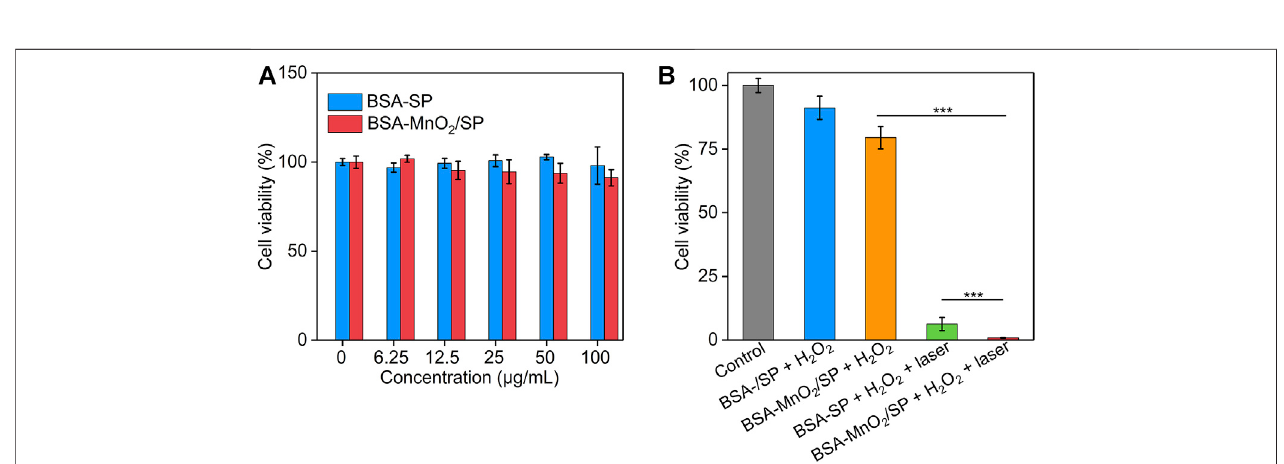
FIGURE5| Evaluationof invitro therapeuticef fi cacy. (A) CellviabilityofHepG2cellsafterincubationwithBSA/SPnanoparticlesorBSA-MnO 2 /SPnanocomposites at differentSPconcentrationsfor24 h. (B) CellviabilityofHepG2cellsafter incubation withBSA/SP nanoparticles orBSA-MnO 2 /SPnanocompositesin thepresenceof H 2 O 2 (100 μ M) without or with 808 nm laser irradiation (1.0 W/cm 2 ) for 5